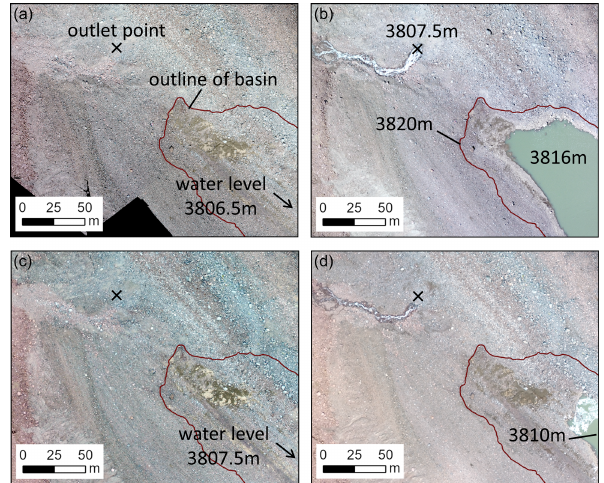
Figure 8. One-day drainage events from Korumdu lake. (a) On 12 August 2016. (b) On 6 August 2017. (c) On 20 July 2018. (d) On 4 August 2019. Images from UAV surveys.